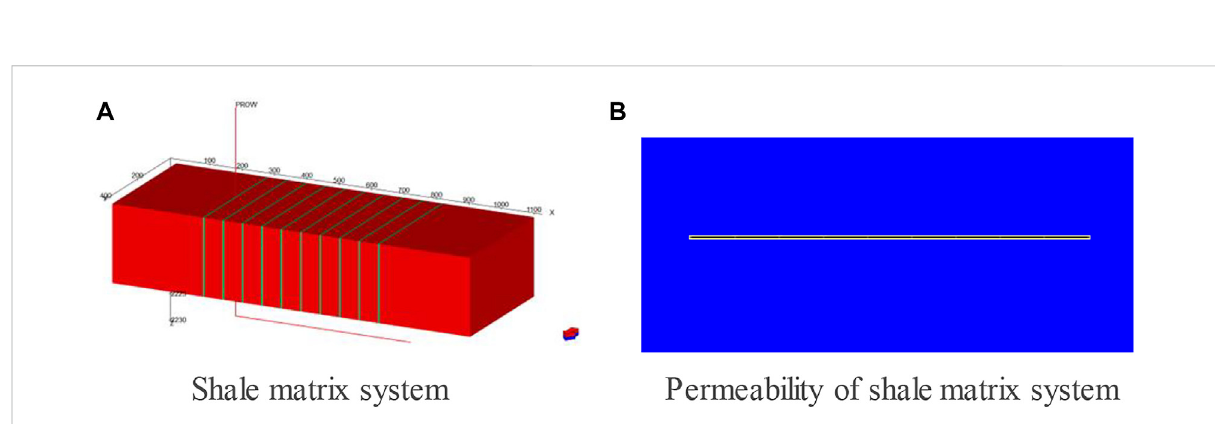
FIGURE 5 (A) Shale matrix system (B) Permeability of shale matrix